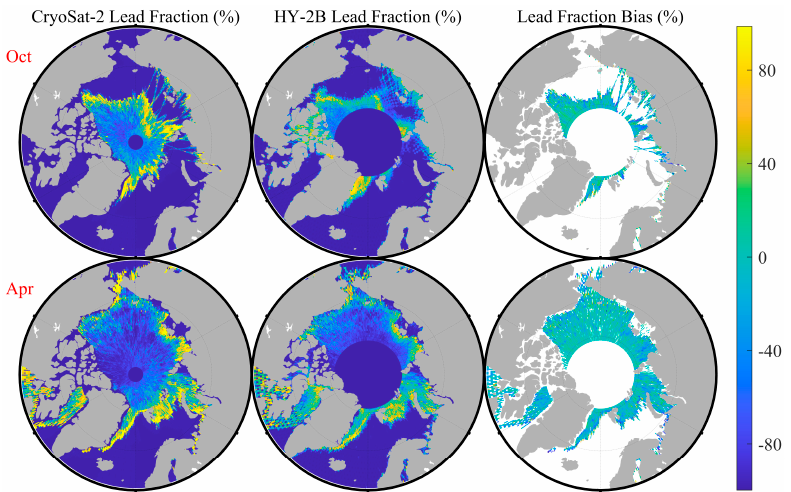
Figure 14. The lead fraction base on the CryoSat-2 and HY-2B from April and October 2019 and the lead fraction bias between them.